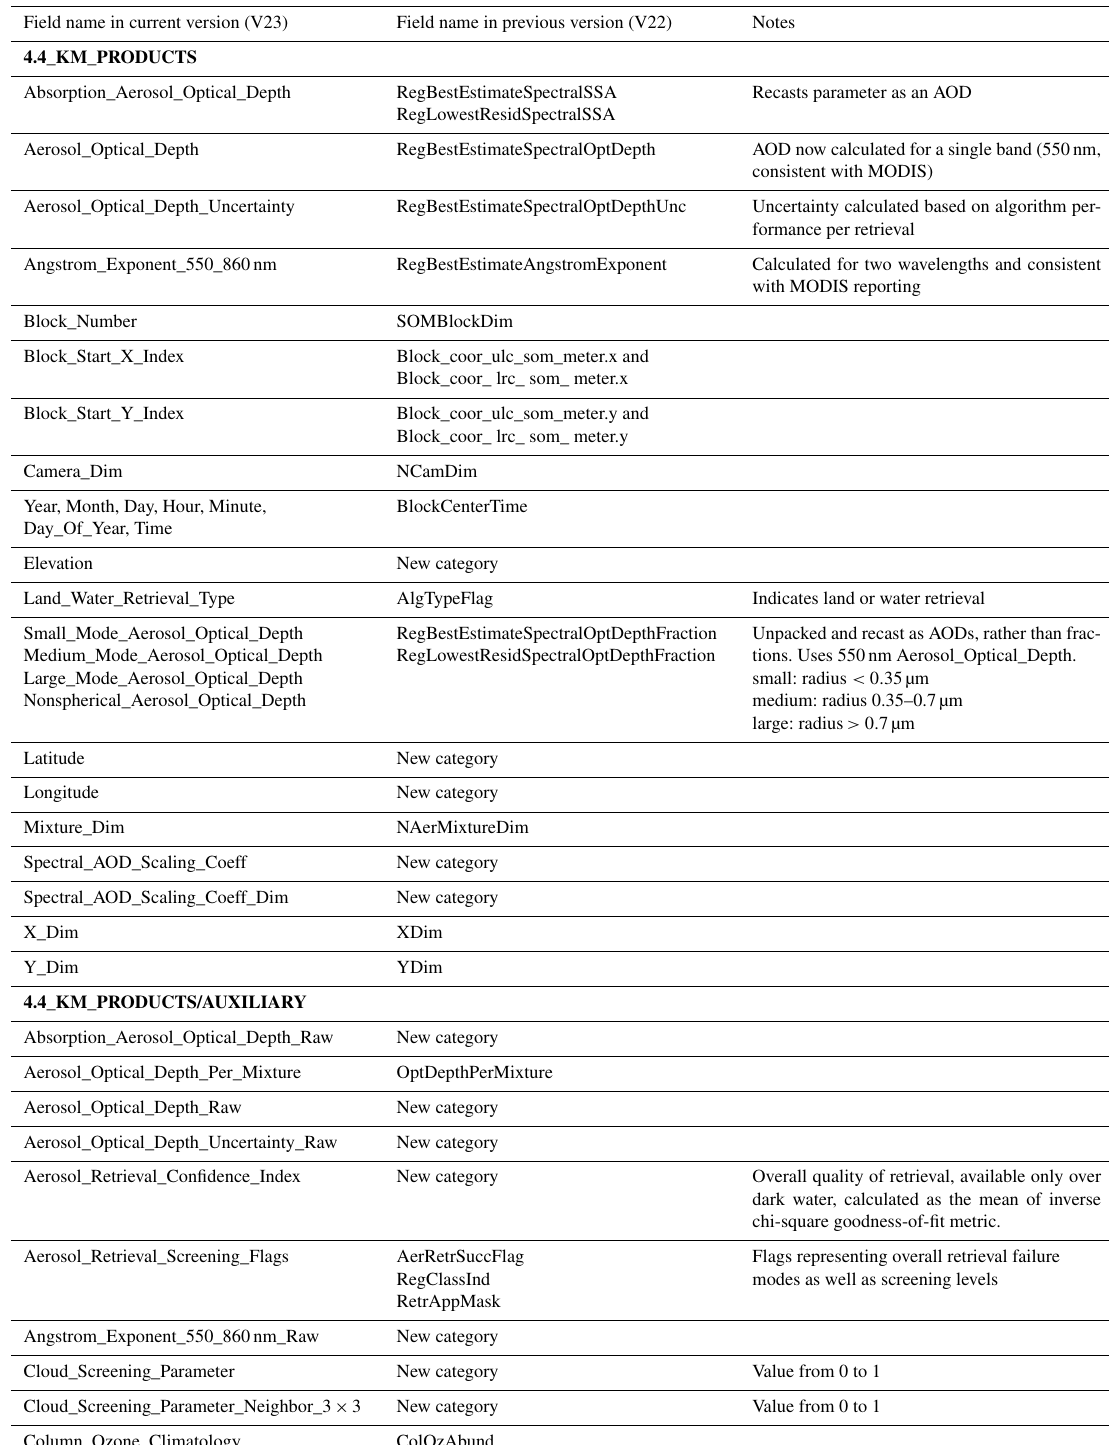
Table A1. List of SDSs. Bold font denotes the names of main data directories in the MISR V23 L2 aerosol